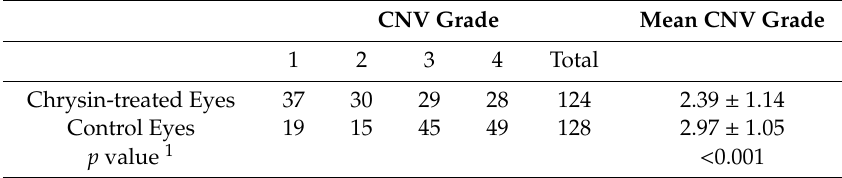
Table 1. Number of CNV lesions in each grade and mean CNV grade of chrysin-treated and control rat